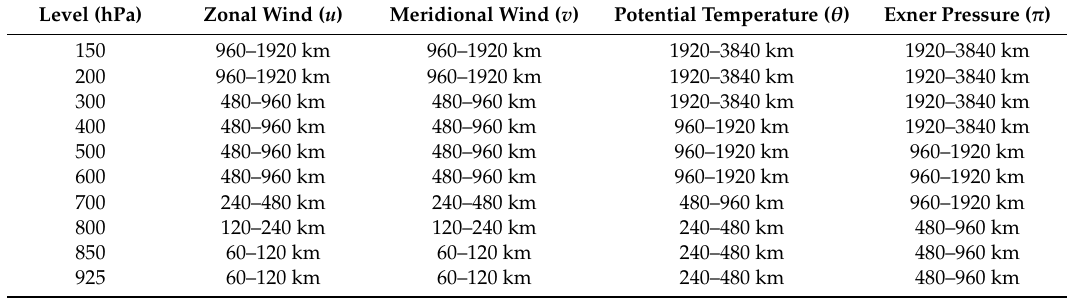
Table 2. The scale-selection scheme of the filtering of various variables in di ff erent levels (w1–w2). Level (hPa) Zonal Wind ( u